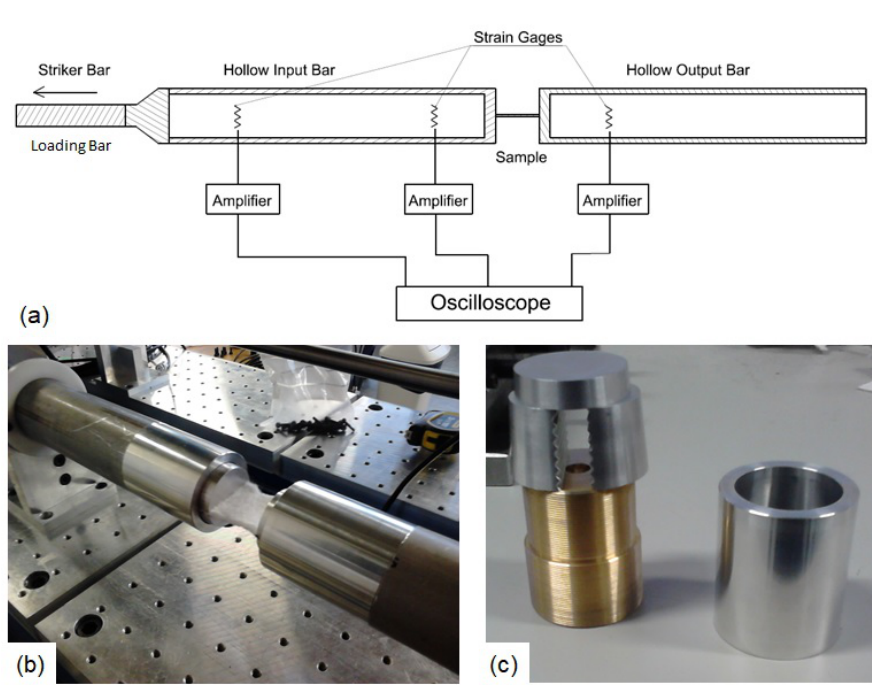
Figure 1. Split-Hopkinson tensile bar experimental set up. ( a ) Schematic of the different components of the SHTB, ( b ) gripped specimen between bar ends and ( c ) aluminium and brass components of the